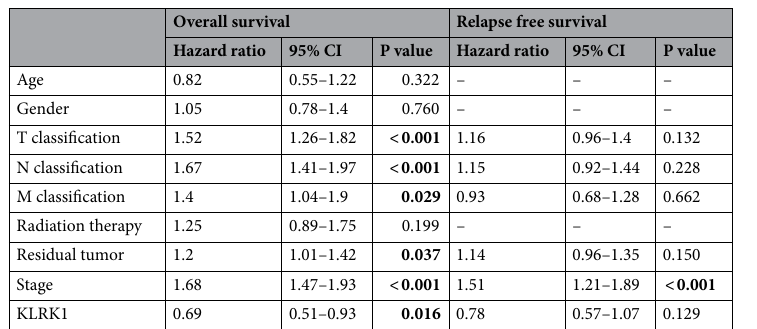
Table 4. Univariate analysis of overall and relapse free survival in patients with lung adenocarcinoma cancer.